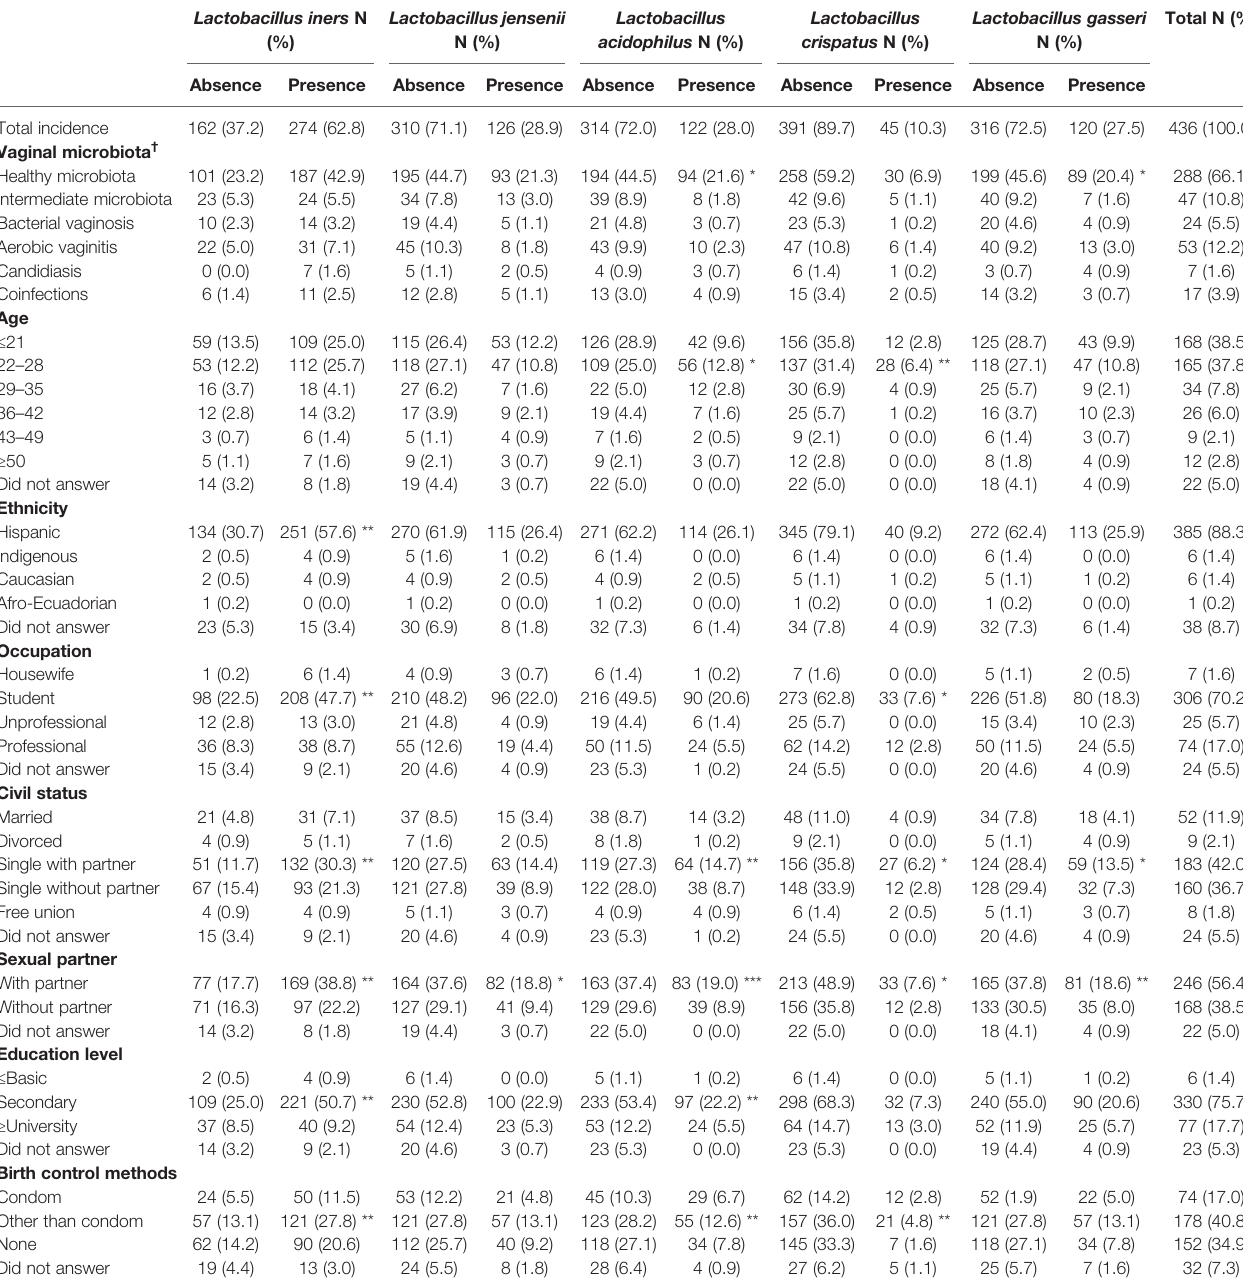
TABLE 1 | Identi fi cation of the main vaginal Lactobacillus species among the population set of the study realized by Salinas and colleagues (2020). Lactobacillus iners N